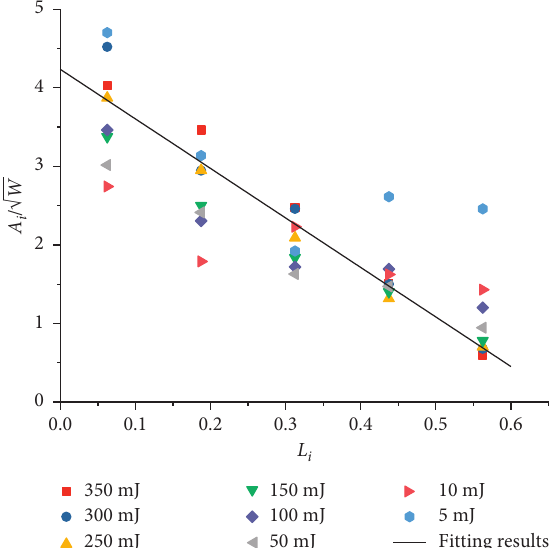
Figure 6: Attenuation of the maximum tensile displacement with distance to disturbance